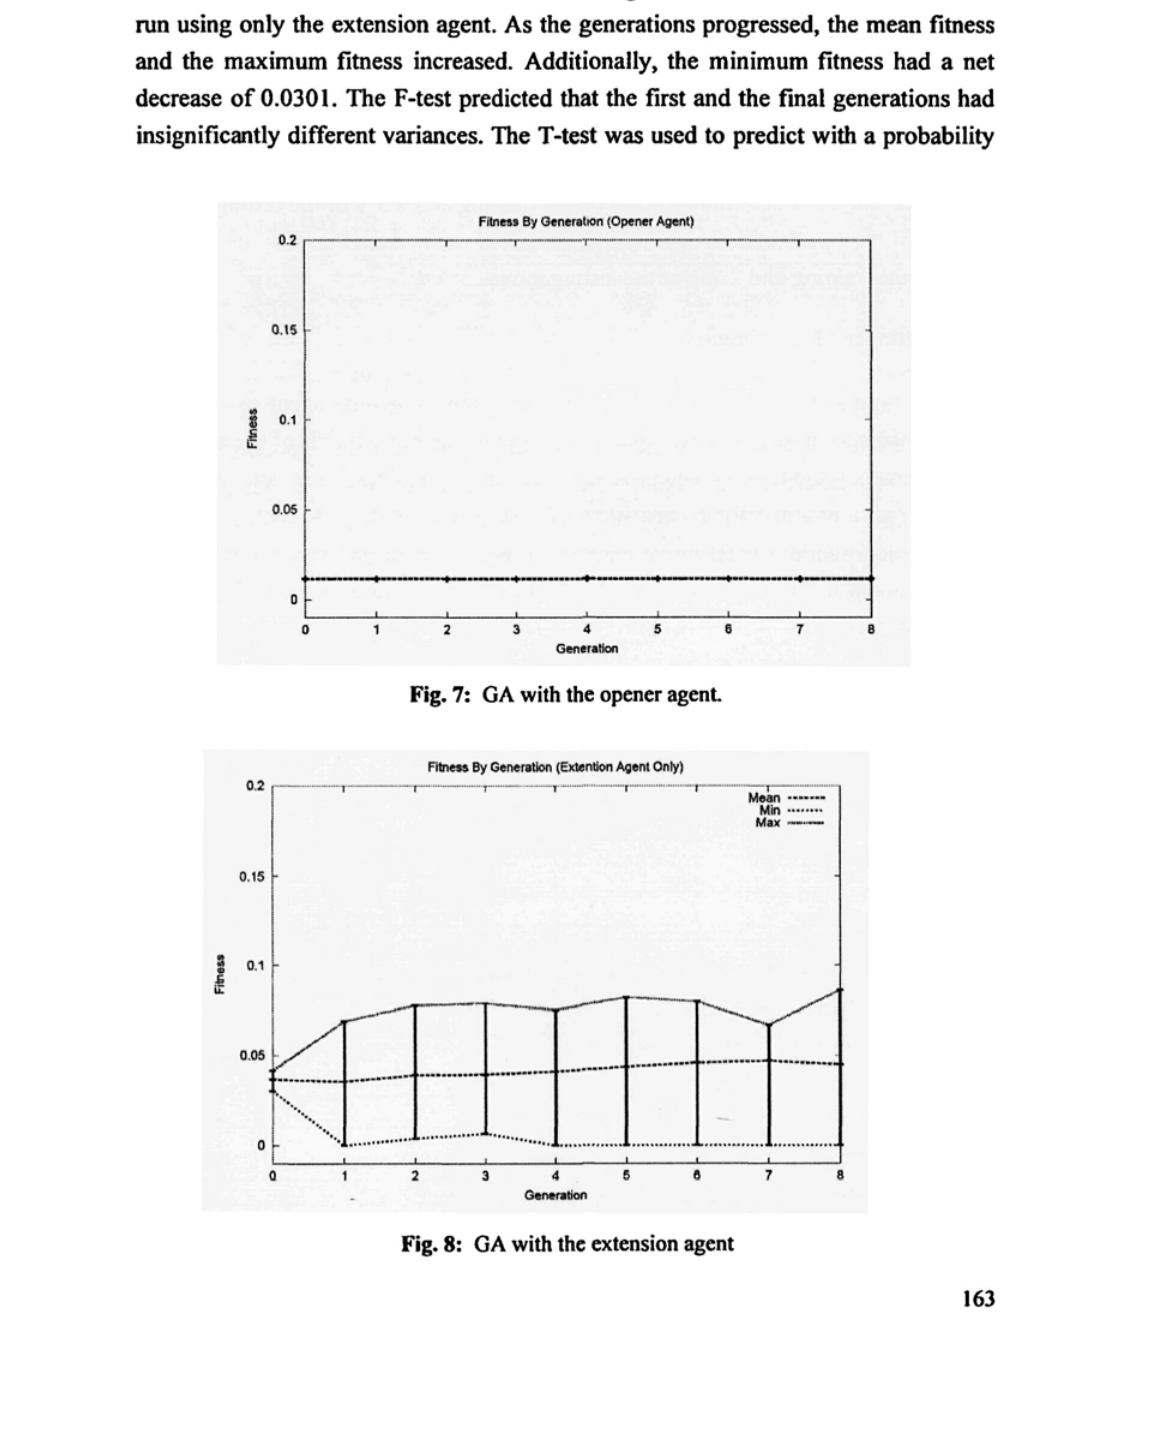
Fig. 7: GA with the opener agent.